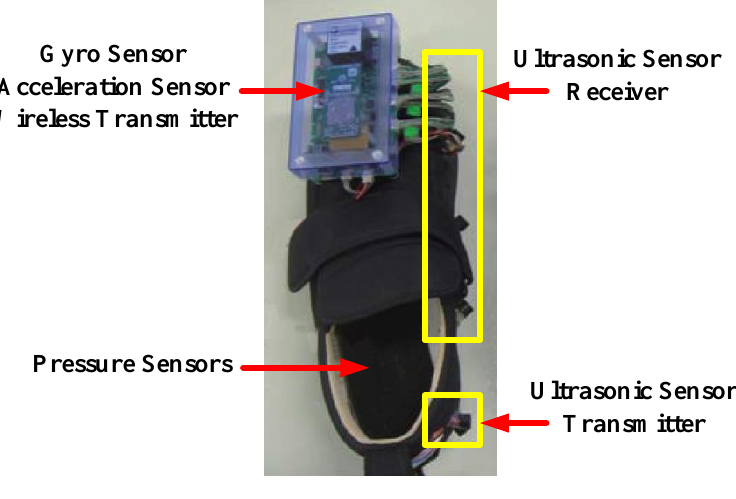
Figure 27. “GaitGuide” shoe prototype. Modified from